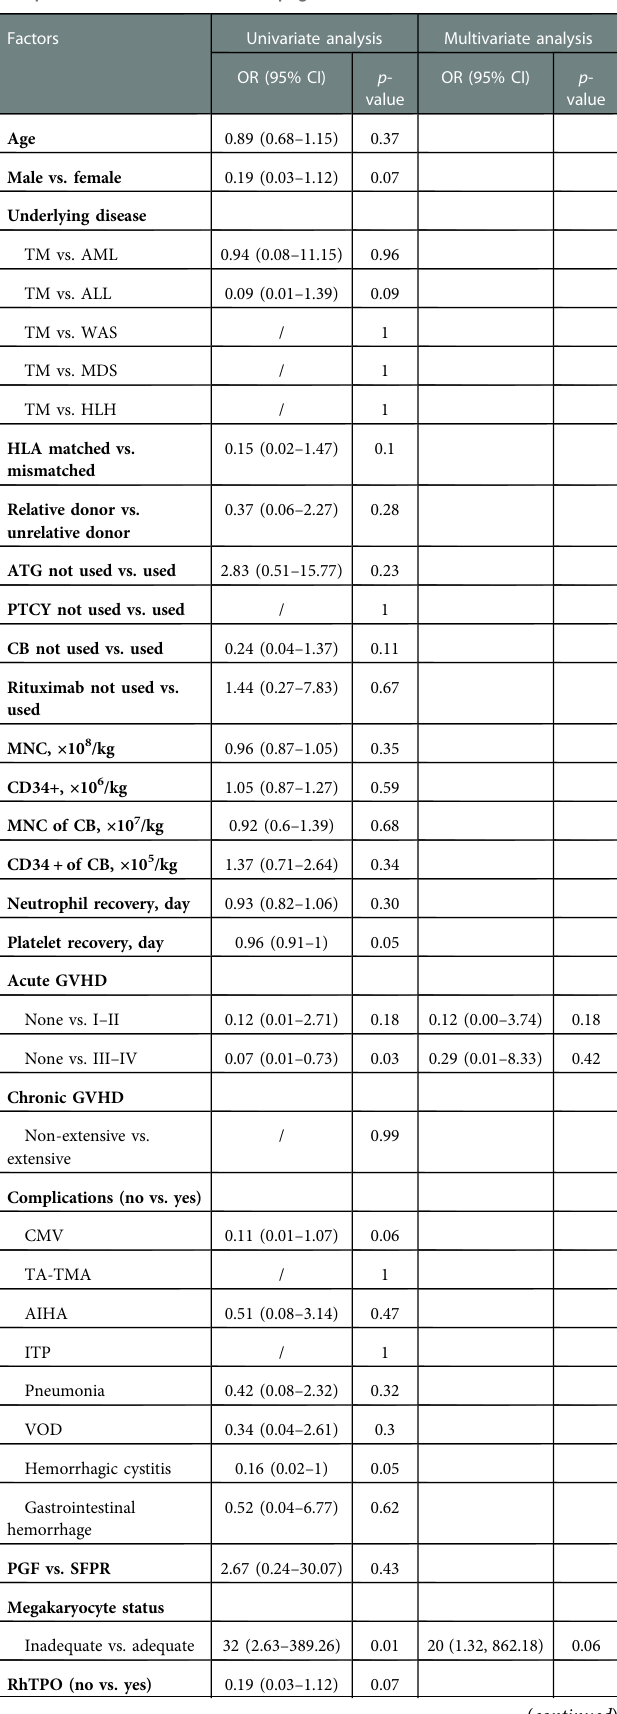
TABLE 3 Univariate and multivariate analysis of risk factors affecting complete remission of